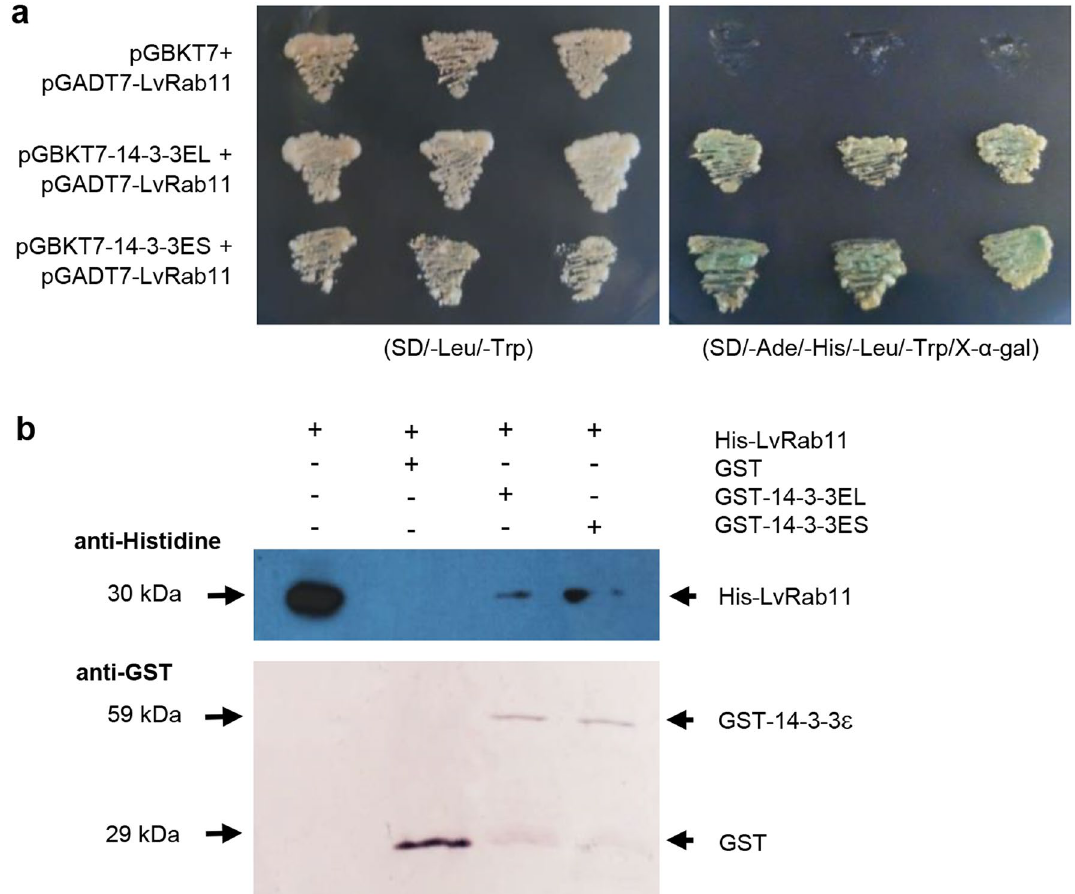
Figure 1. Evaluation of the 14-3-3ε and LvRab11 interaction. ( a ) Interaction was demonstrated by a yeast two- hybrid assay. AD-LvRab11 and BD-14-3-3ES or BD-14-3-3EL were co-transformed into the AH109 strain. Yeast cells with the two plasmids were cultured in SD-Leu/-Trp medium, selecting for the presence of both plasmids, and in SD-Leu/-Trp/-His/-Ade/X-α-gal medium, in which only the yeast cells with protein interactions were capable of growth and showed blue colonies. ( b ) Interaction was demonstrated by GST pull-down assays. GST pull-down assays using purified GST-14-3-3ES and GST-14-3-3EL recombinant proteins detected an interaction GST-14-3-3ES and GST-14-3-3EL proteins in binding reactions were detected with a rabbit anti-goat alkaline phosphatase-conjugated antibody bound to a goat anti-GST antibody (bottom